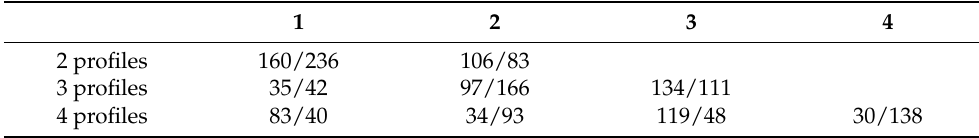
Table 4. Number of individuals for each model of profiles (SAS/TRAS).